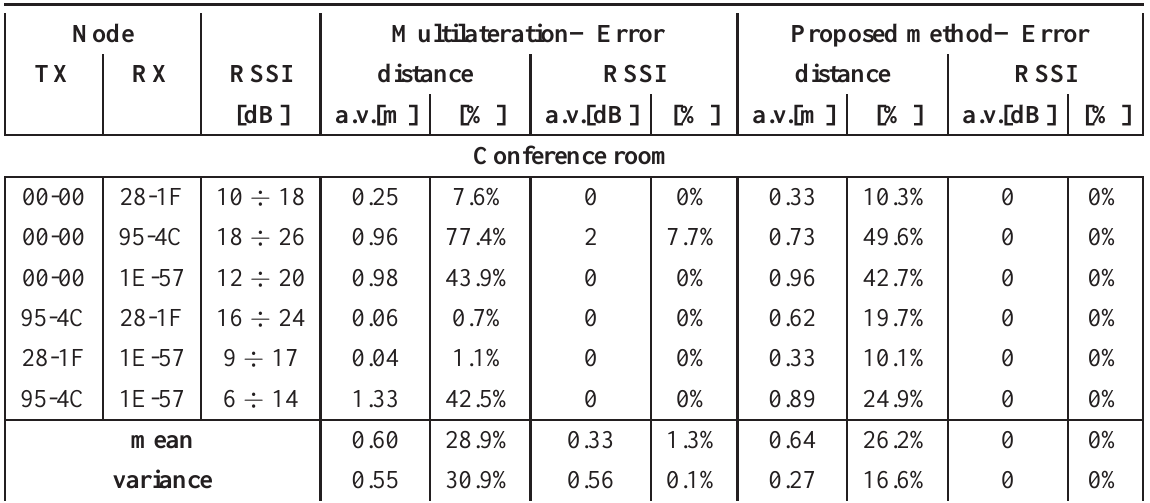
Table 4. Error on the distance and RSSI estimations obtained using 10